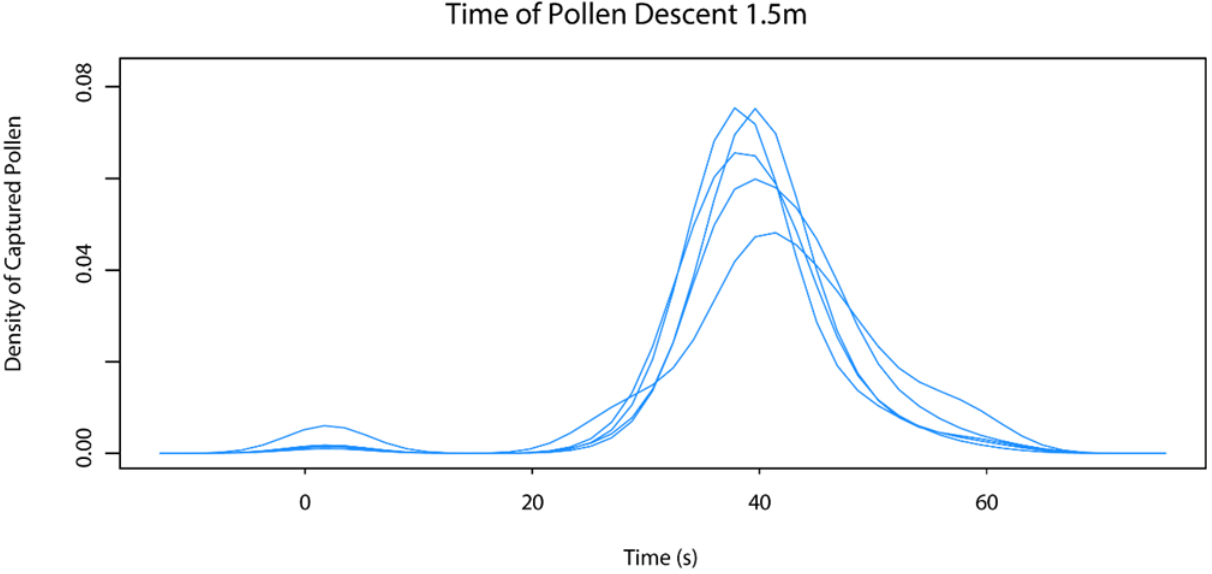
Figure 5. The kernel density plots of D. obovata pollen grains captured per slide for the five trials measuring descent times 1.5 m through still air in a drop